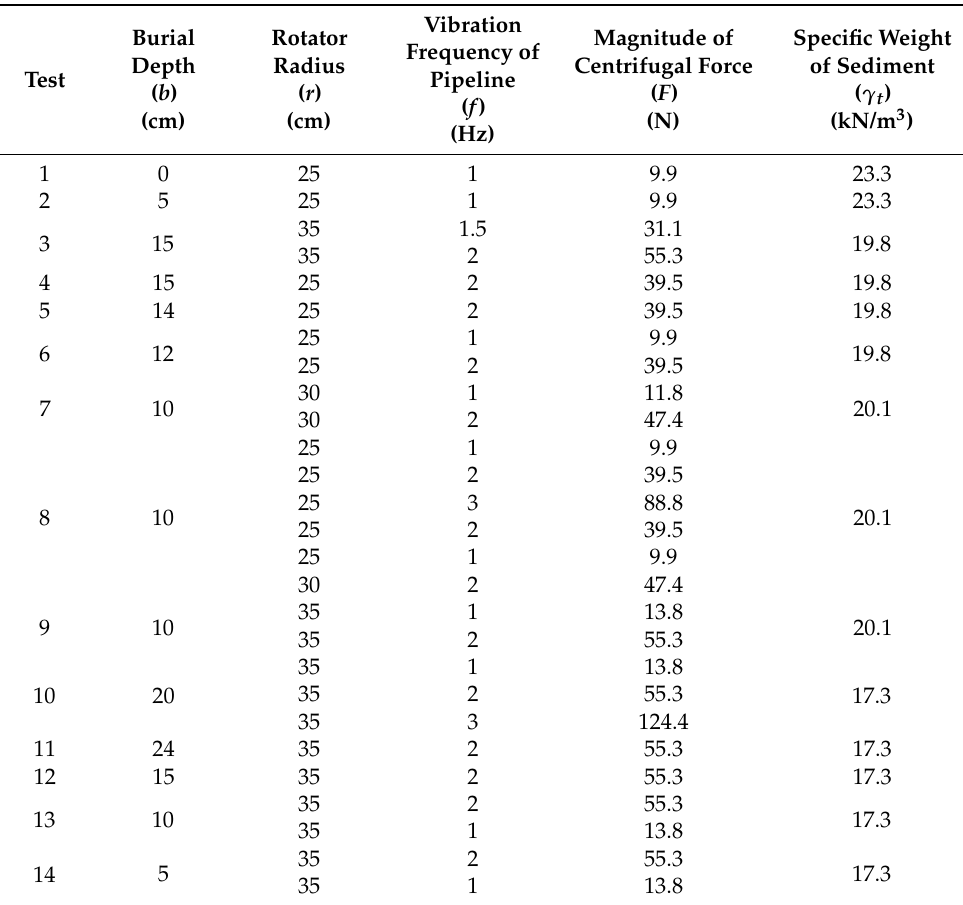
Table 1. Test conditions.